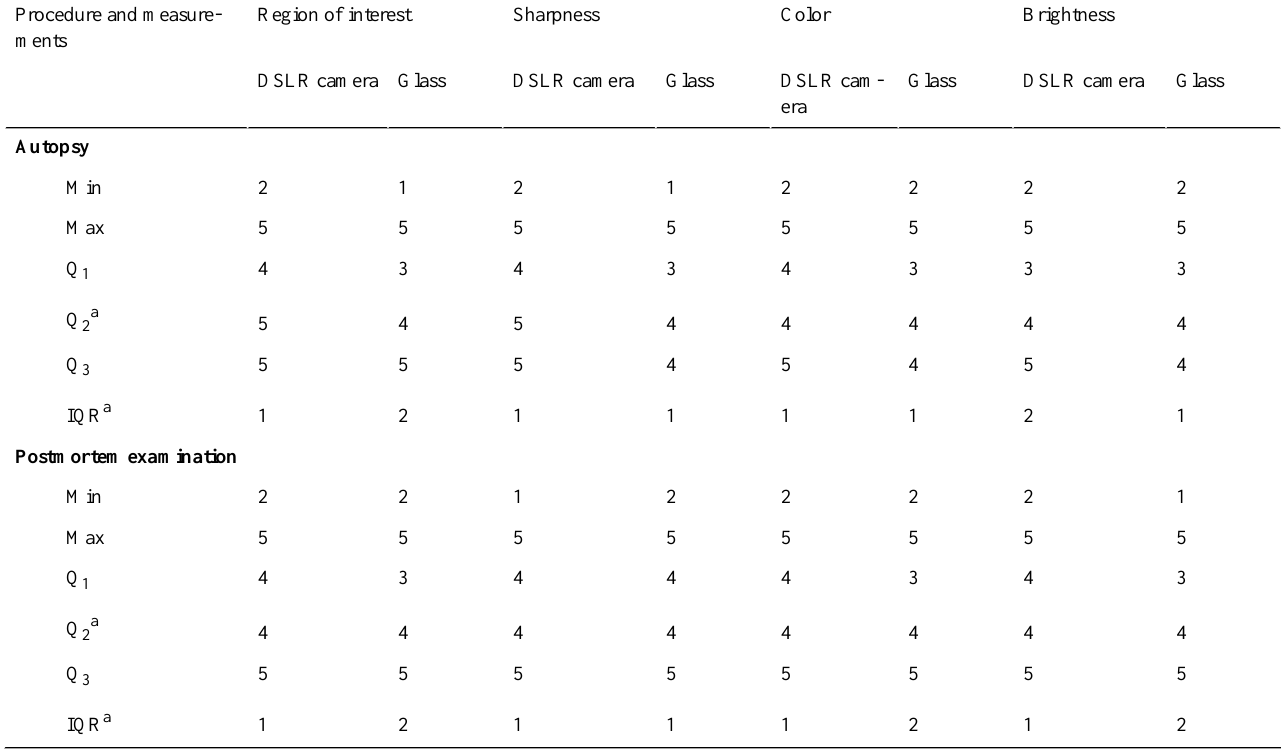
Table 4. Minimum (min) and maximum (max) measurements, first quartile (Q1), second quartile (Q2, median), third quartile (Q3), and interquartile